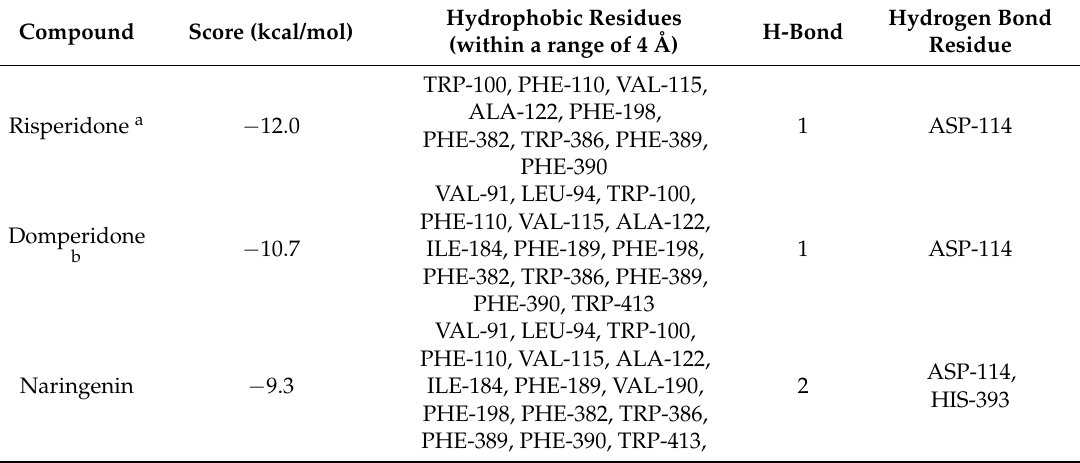
Hydrogen Bond H-Bond Residue